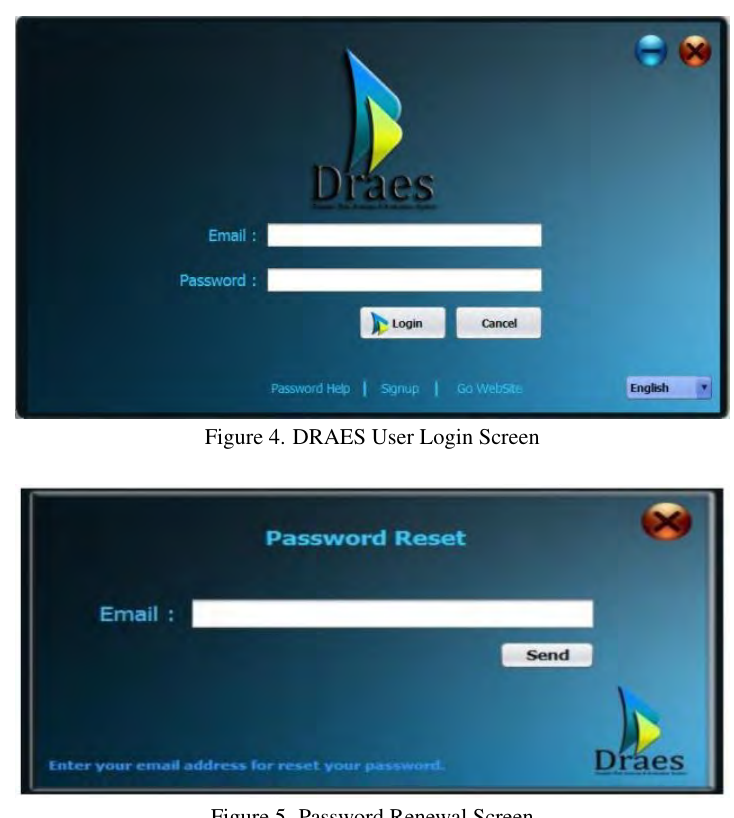
Figure 5. Password Renewal Screen